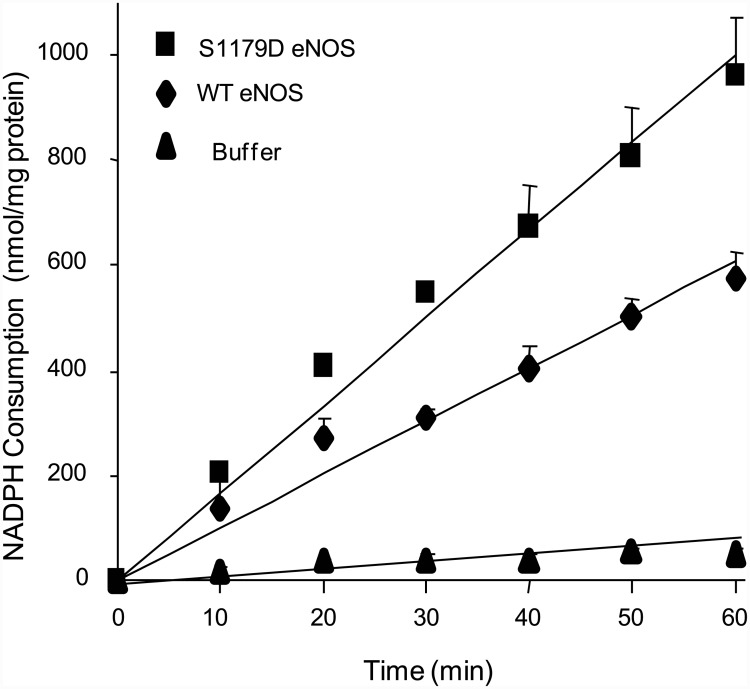
S1179D eNOS has higher NADPH consumption than WT eNOS.NADPH oxidation was monitored spectrophotometrically at 340 nm in the reactions containing 50 mM Tris-HCl, pH 7.4, 50 μM NADPH, 0.5 mM Ca2+, 15μg/ml eNOS, and 10μg/ml calmodulin in presence or absence of 300nM eNOS. As shown, there was minimal NADPH consumption in the absence of eNOS, likely representing non-enzymatic oxidation (▲). WT eNOS caused marked NADPH oxidation in the absence of BH4 and L-arginine (♦). S1179D eNOS has higher NADPH oxidation rate than WT eNOS (■). Data shown are the mean±S.E. from three independent experiments.